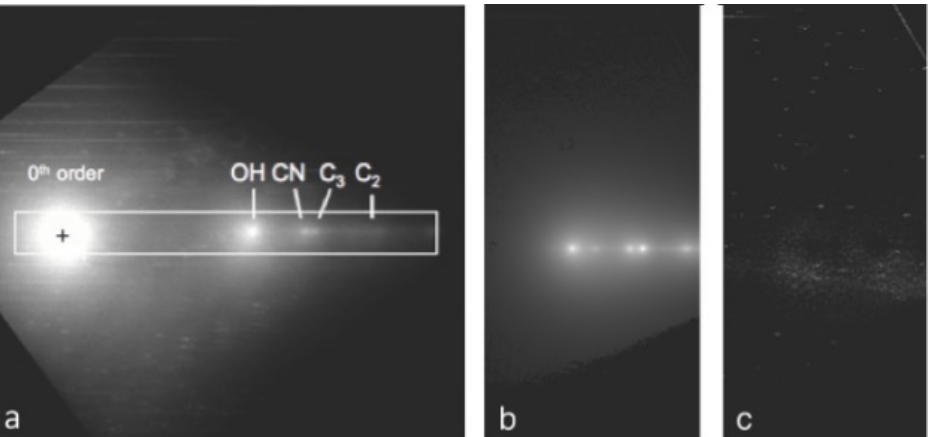
Figure 8. UVOT Grism spectroscopy combined with forward modeling allows us to reliably measure production rates and abundances with Swift /UVOT. ( a ) observed, stacked grism image of comet C/2007 N3 (Lulin); ( b ) modeled grism image; ( c ) residual image where the 2D model image is subtracted from the observed grism image, adapted from Bodewits et al.